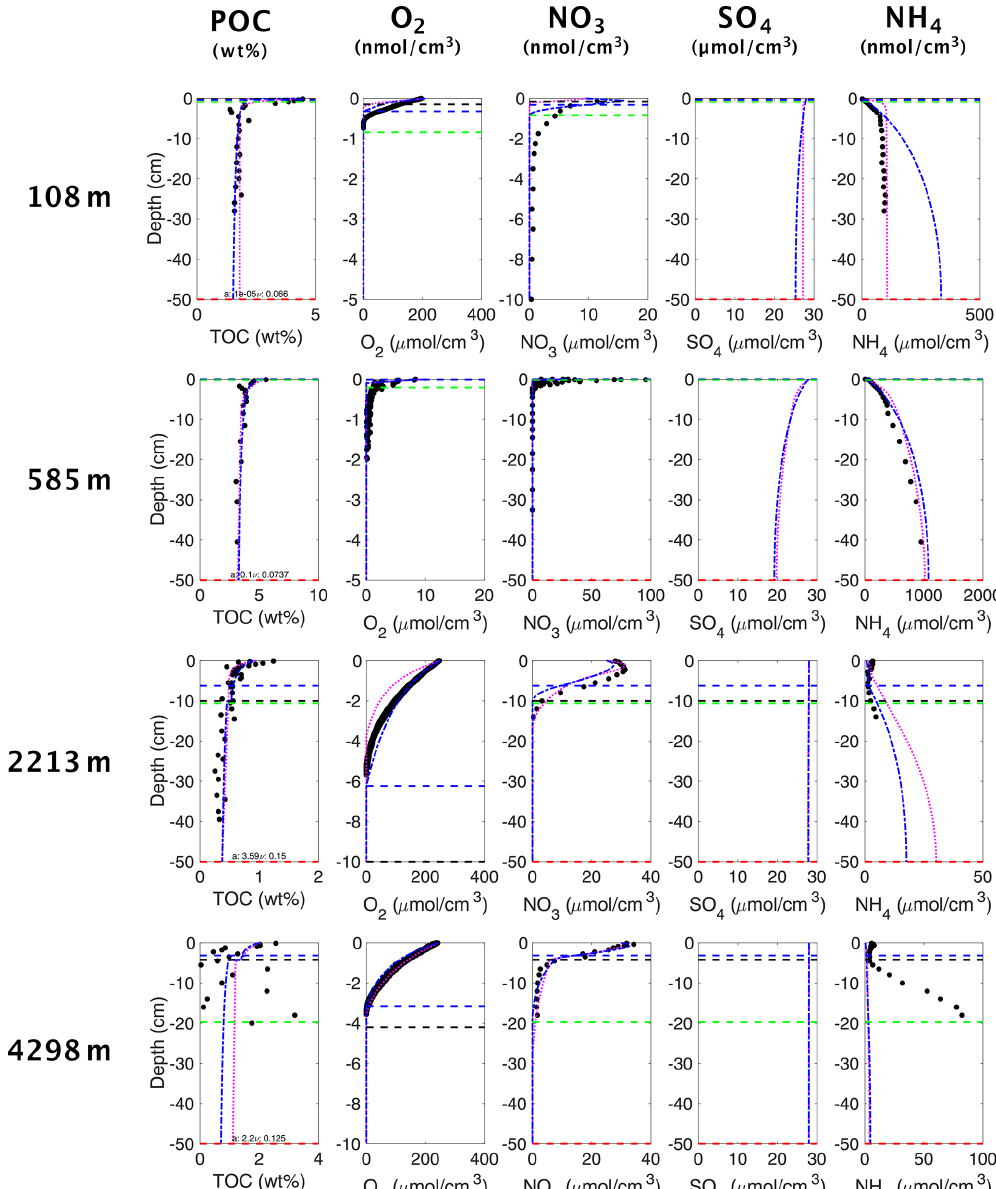
Figure 3. OMEN-SED-RCM (blue curves), 2G OMEN-SED (magenta curves) (Hülse et al., 2018) and observed (filled dots) solid-phase and dissolved pore water profiles for four different sediment cores. Note that different scales are used for different stations. The horizontal dashed lines in each panel indicate the bioturbation depth (black) and the penetration depths of oxygen (blue), nitrate (green) and sulfate (red) as calculated by the updated